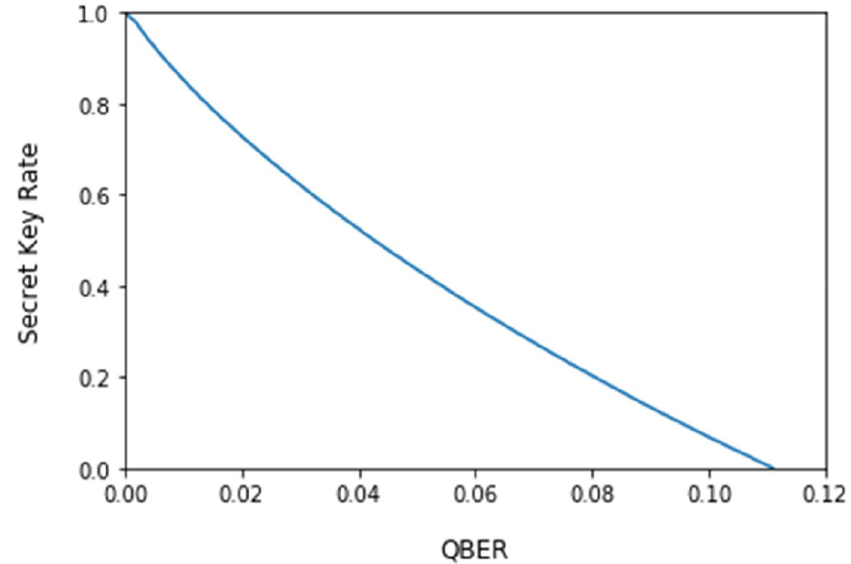
Figure 2. The secret key rate under the different QBER